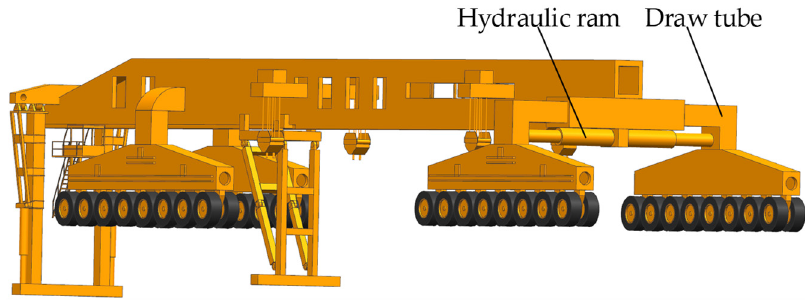
Figure 22. Preliminary solution of mobile bridge erecting machine.